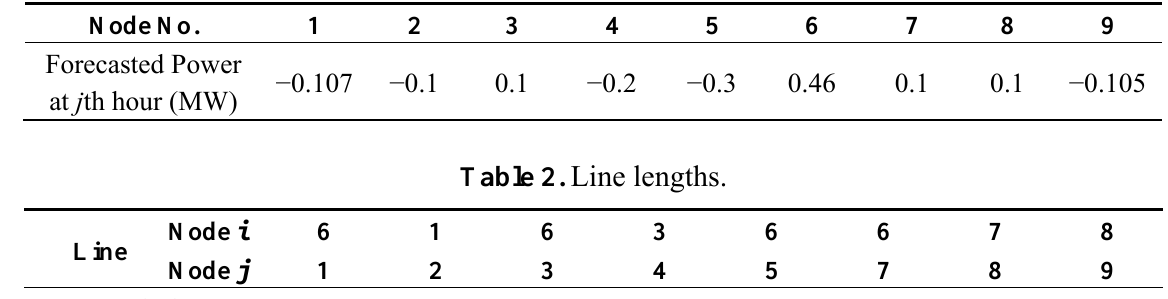
Table 1. Forecasted power of each equivalent node at j th hour.